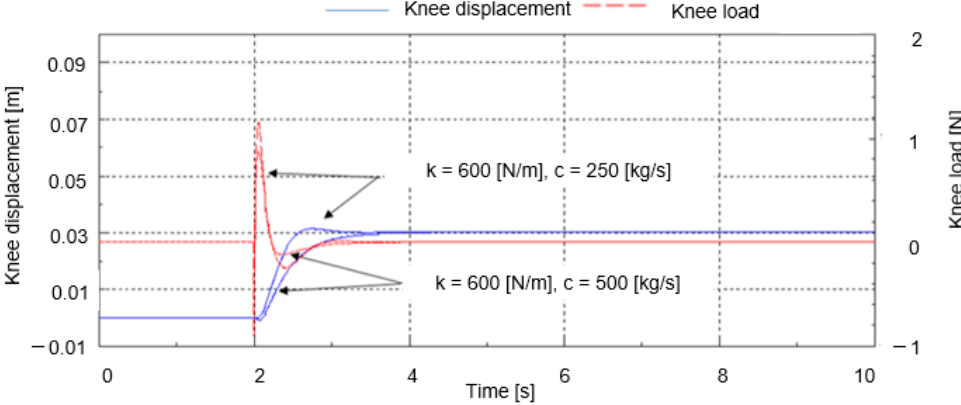
Figure 19. Comparison of device dumper and spring constant.